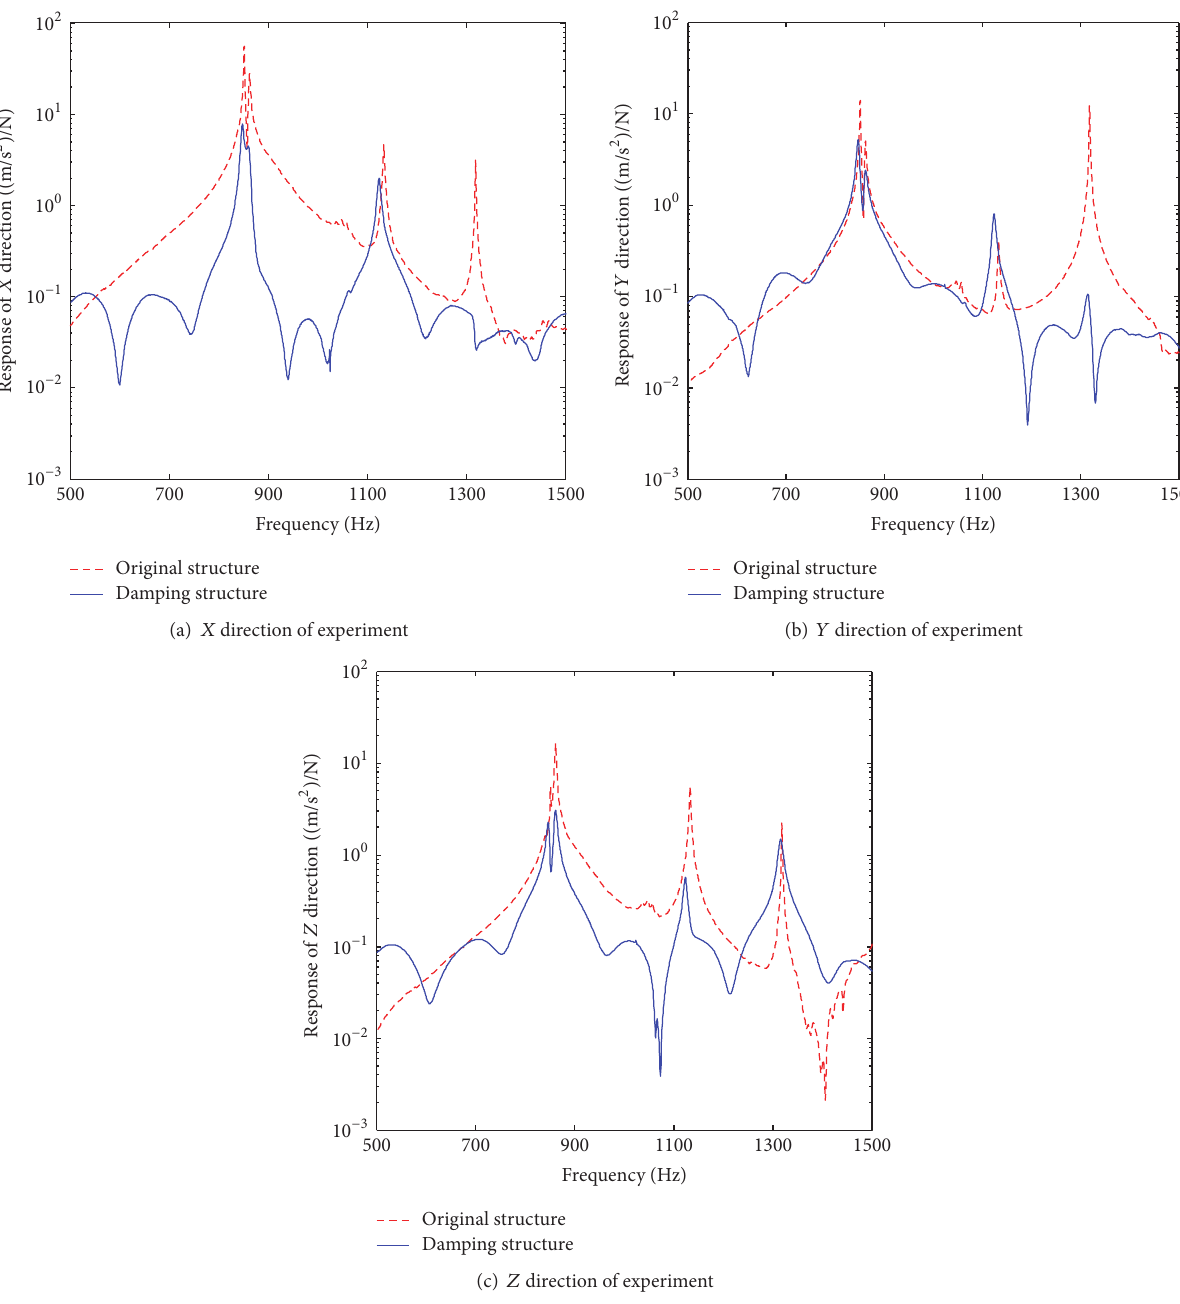
Figure 14: Experiment frequency response curve of the headstock.